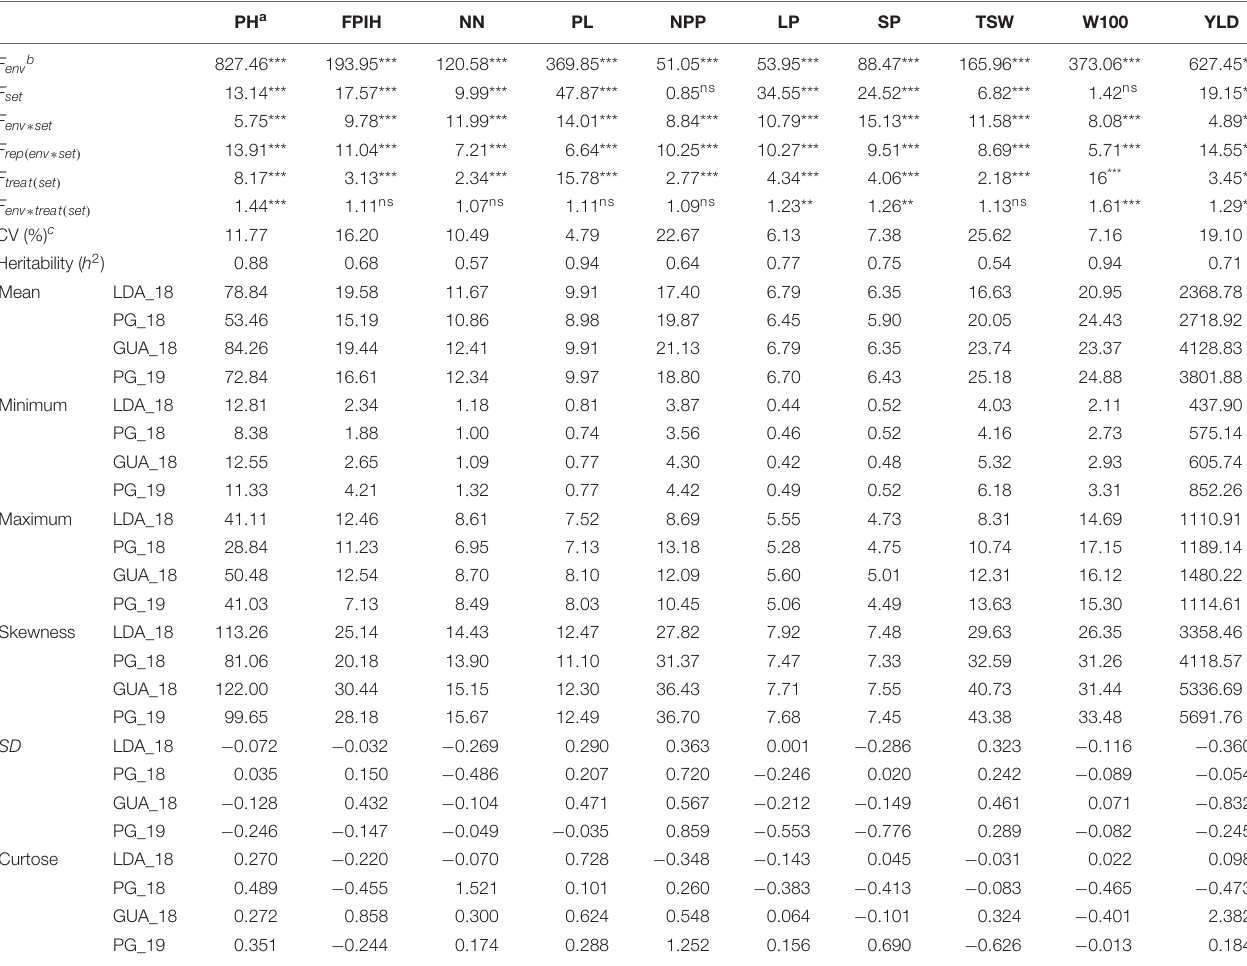
TABLE 1 | Analysis of variance and descriptive statistics for morpho-agronomic traits evaluated in common bean accessions belonging to the Brazilian Diversity Panel (BDP) evaluated in four